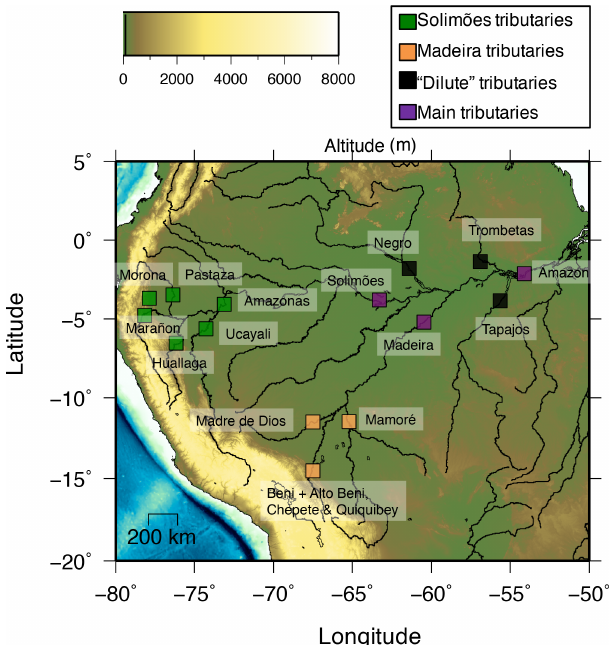
Figure 1. Map of the Amazon Basin and the locations of the sam- pling